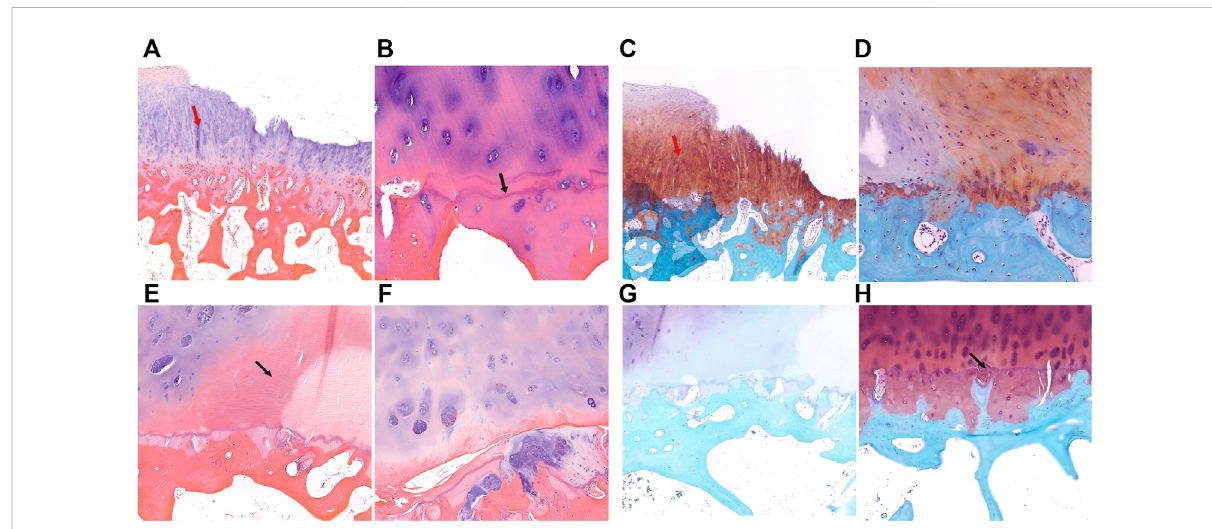
FIGURE 2 HE and safranin O-fast green staining of cartilage and subchondral bone of the tibial plateau in KBD patients. (A,B) , HE staining of the medial tibial plateau. The red arrow shows cartilage fi brosis, and the black arrow shows tidemark replication (magni fi cation: (A) , ×5; (B) , ×10). C-D, Safranin O-fastgreenstainingofthemedialtibialplateau(magni fi cation: (C) ,×5; (D) ,×10). (E,F) ,HEstainingofthelateraltibialplateau.Theblackarrowshows chondrocyte necrosis and ossi fi cation (magni fi cation: (E) , ×5; (F) , ×10). (G,H) , Safranin O-fast green staining of the lateral tibial plateau. The black arrow shows vascular invasion (magni fi cation: (G) , ×5; (H) ,